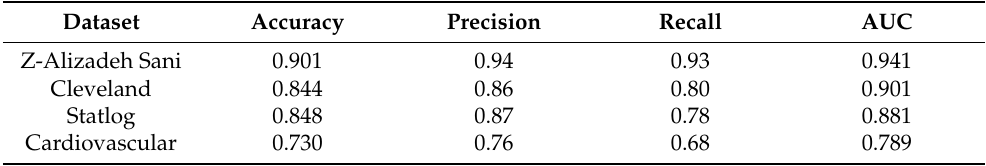
Table 12. Confusion matrix